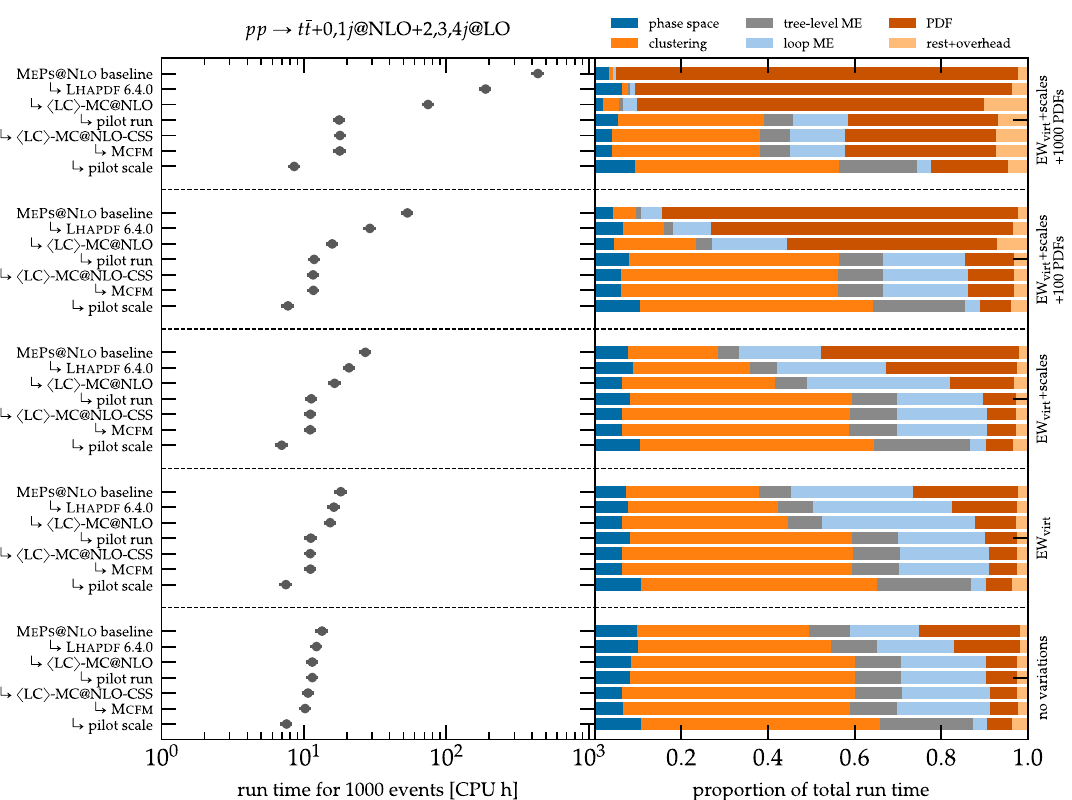
Fig. 4 Reduction in overall run time for different performance improvements, combined with the breakdown of the overall run time into a high-level calculation composition. The timing is assessed by producing 1000 partially unweighted particle-level events for pp →